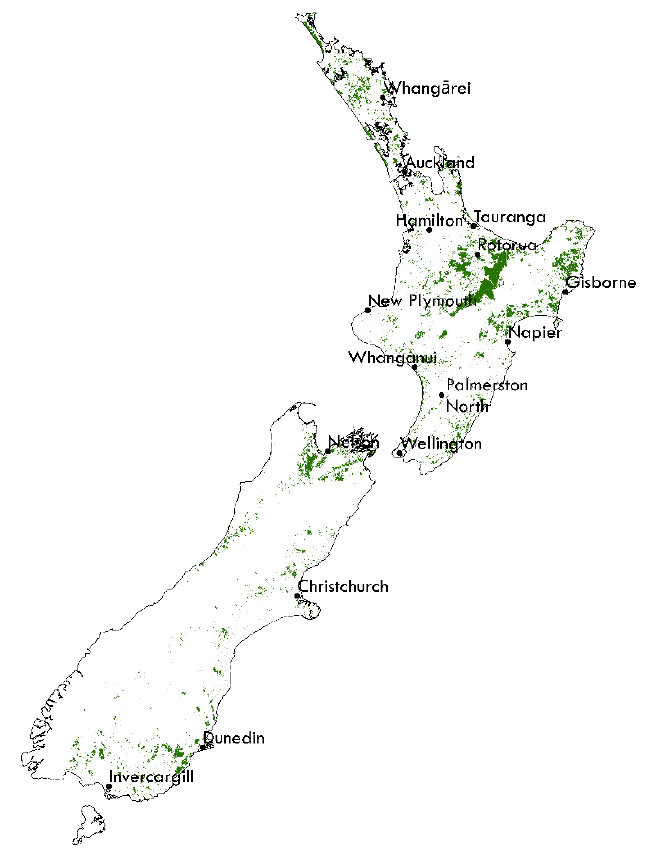
Figure 2. Production plantation forest areas in New